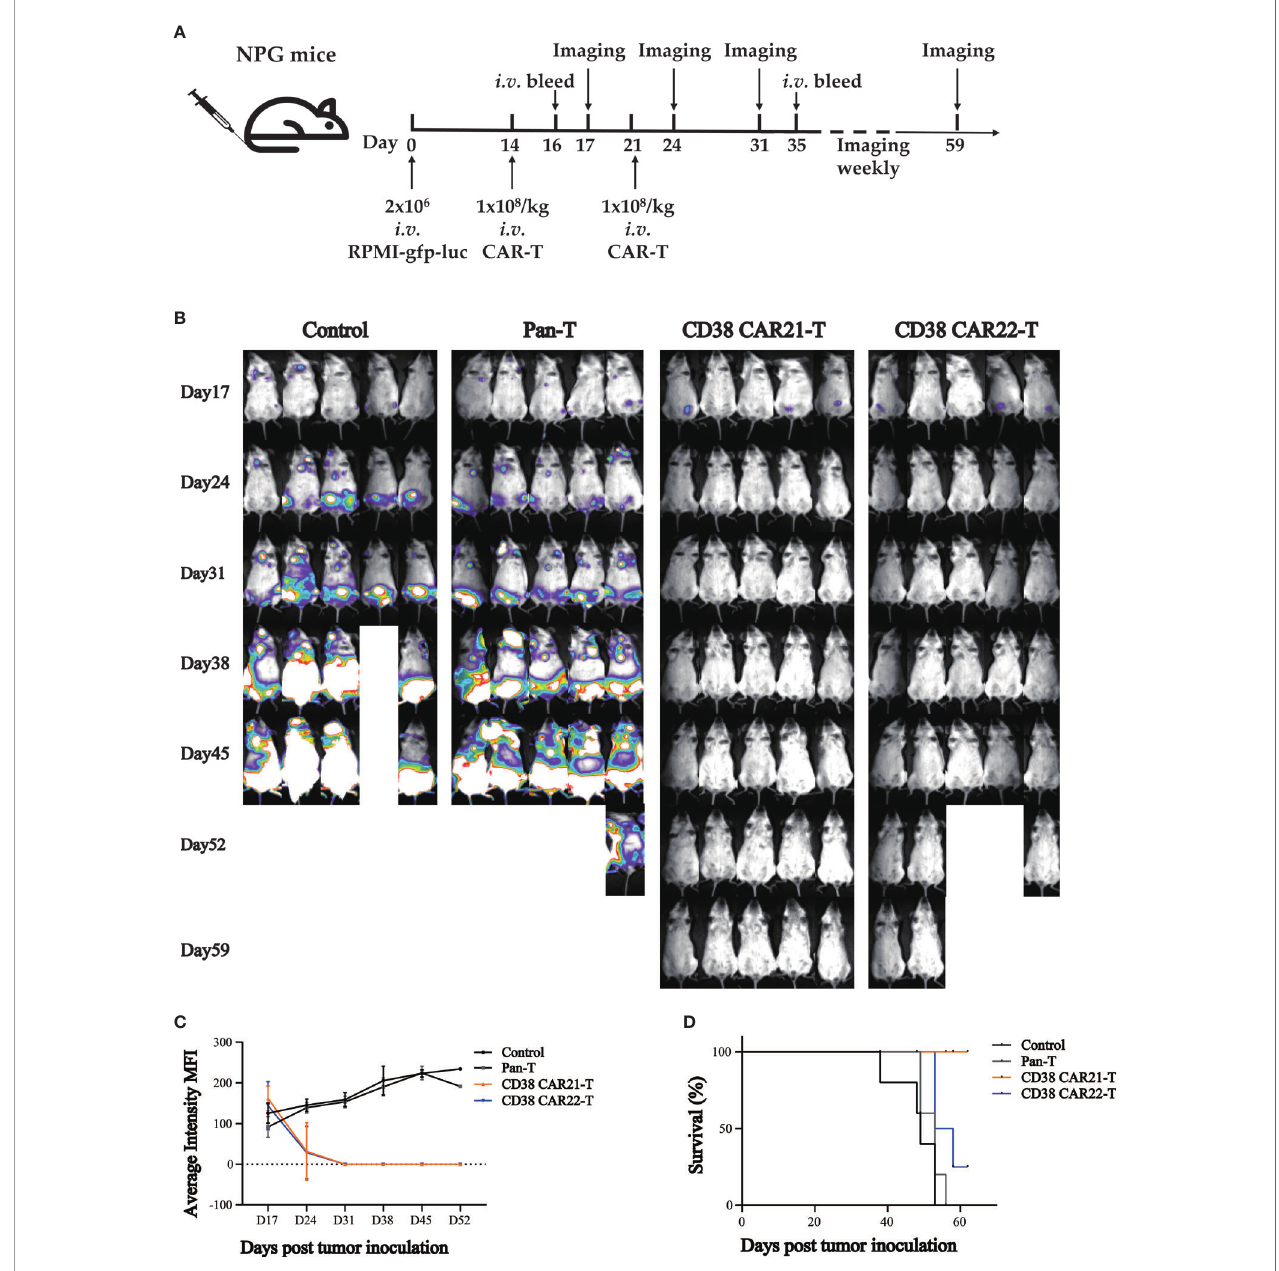
FIGURE 3 | CD38 CAR-T cells exhibited signi fi cant antitumor activities in a mouse xenograft tumor model. (A) Experimental design indicating tumor cells, timeline, doses, and imaging time points. Mice were randomized after tumor engraftment. T cells from two independent donors were used (n=5). (B) Mice were assessed by bioluminescence imaging once a week starting 3 days after the fi rst injection of CAR-T cells. (C) Tumor burden was monitored weekly and presented as the average intensity. (D) Survival analysis of mice after tumor cell inoculation.n= 5 mice per